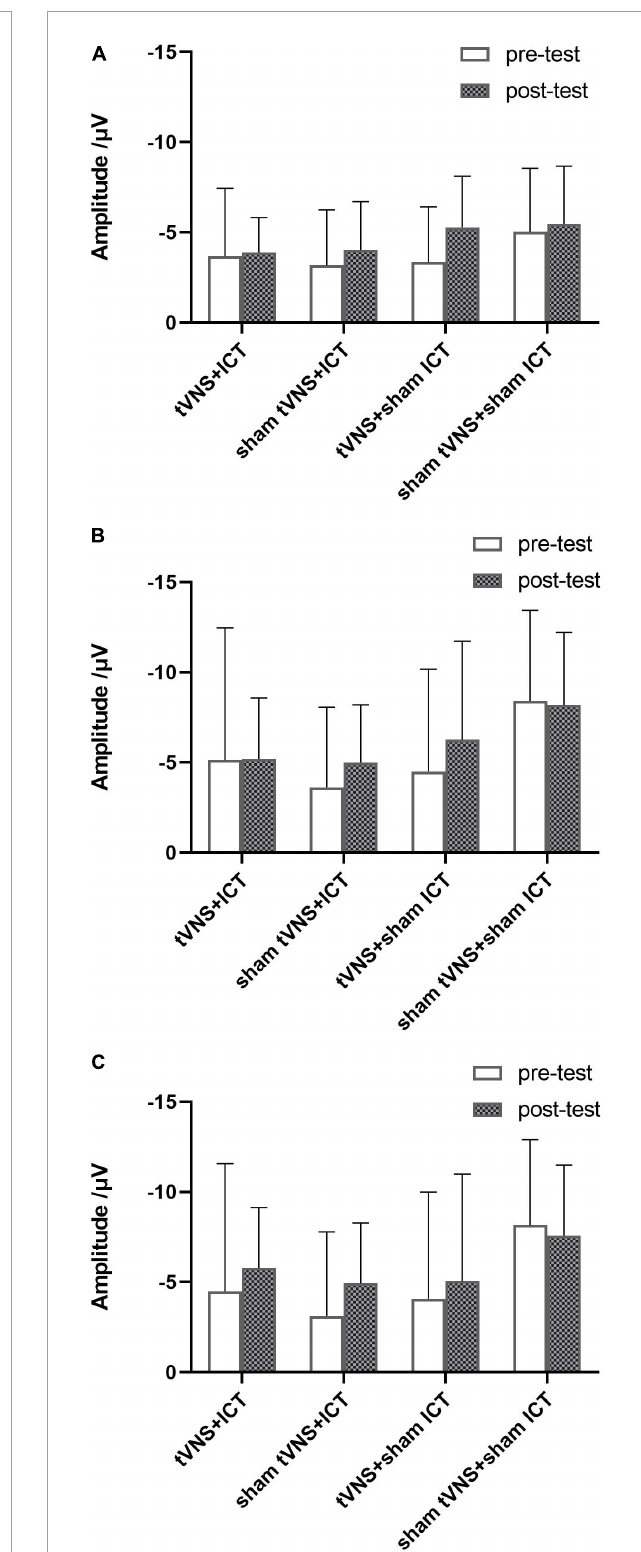
FIGURE3 Summary of signal-N2 amplitude in SST. (A) Signal-N2 amplitude between pre- and post-test for each group in frontal region. (B) Signal-N2 amplitude between pre- and post-test for each group in fronto-central region. (C) Signal-N2 amplitude between pre- and post-test for each group in central region. Error bars represent the standard deviation of the